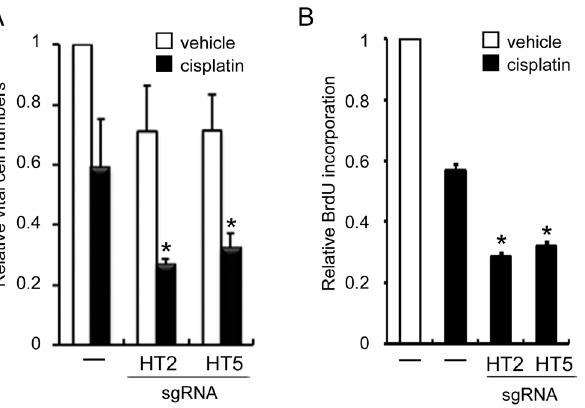
Figure 4. Effects of sgRNA targeting cyclin D1 on viable cell numbers and cell proliferation. HSC-3 cells were plated at 1 6 10 5 cells/well in 24 well dishes, and then cultured for 24 h. sgHT2 or sgH5 was added at 200 nM and then cultured for a further 24 h. Cisplatin (10 m M) or vehicle was added to cells, after which the cells were cultured for 72 h. The living cell numbers were quantitated as described in Materials and Methods (A). Cell proliferation was measured by BrdU incorporation using an ELISA kit (B). The relative living cell numbers and BrdU incorporation in the absence of both sgRNAs and cisplatin are adjusted to 1. Each assay represents a separate experiment performed in triplicate. Data are means ¡ S.D. * P ,